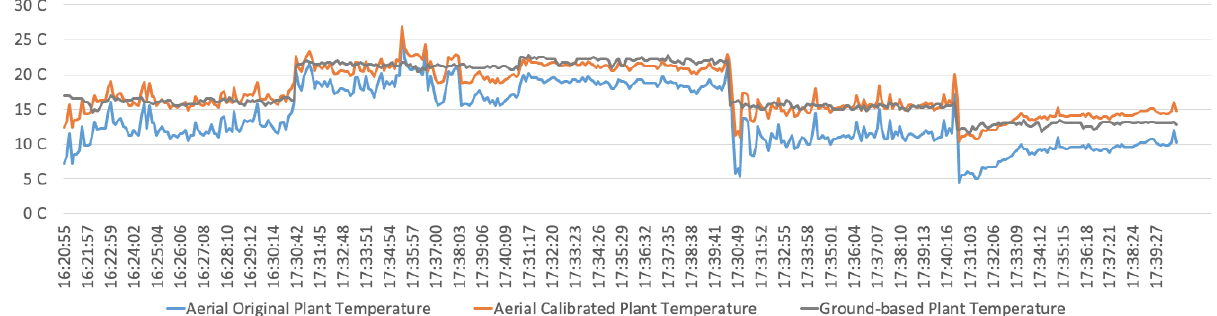
Figure 15. Original and calibrated aerial infrared data compared with ground-based